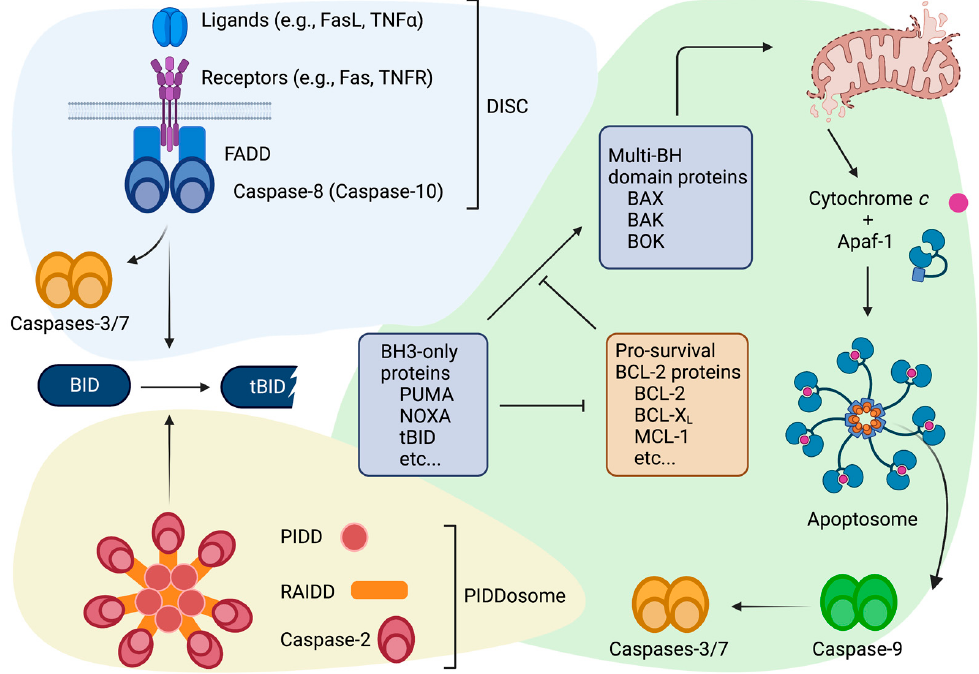
Figure 2. Schematic diagram of the major players in the apoptotic pathways . Three signaling pathways in cells can result in apoptosis. Extracellular stress signals activate the death receptors, which leads to the formation of the DISC complex. Caspases-8 and -10 are then activated by the DISC through dimer- ization. The second pathway is triggered by an intracellular stress stimulus leading to mitochondrial cytochrome c release which is governed by the BCL-2 family proteins. In the cytoplasm, cytochrome c binds to the adaptor protein Apaf-1, which triggers the formation of the caspase-9 activating complex apoptosome. The executioner caspase-3 and -7 are subsequently activated via the proteolytic cleavage by caspase-8 (-10) or caspase-9. The third pathway, which is also triggered by an intracellular signal, results in PIDDosome formation and subsequent activation of the initiator caspase-2. The activation of BID by caspase-2 or caspase-8 (-10) feeds into the BCL-2 family-mediated cytochrome c release.